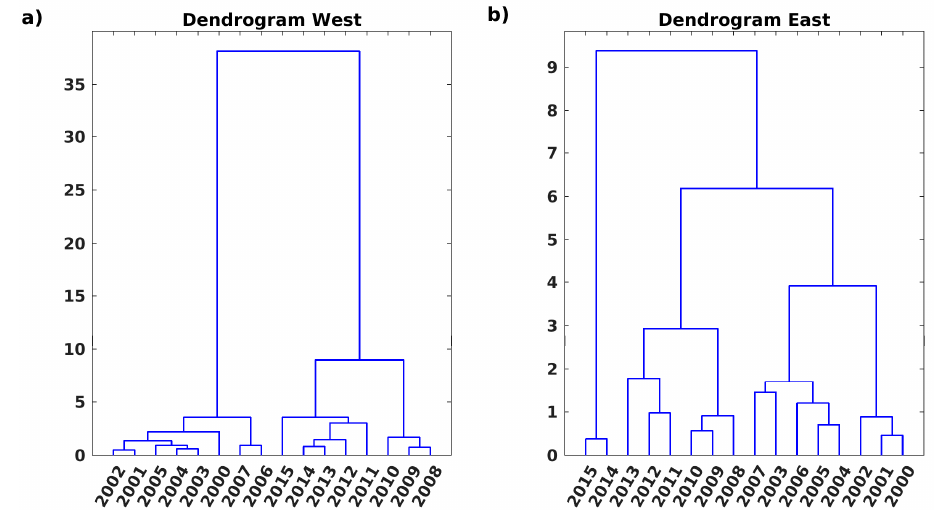
Figure 4. Dendrogram (hierarchical clustering) for clr -transformed container traffic of ports in the Mediterranean, 2000–2015 considering two regions: ( a ) West and ( b ) East.